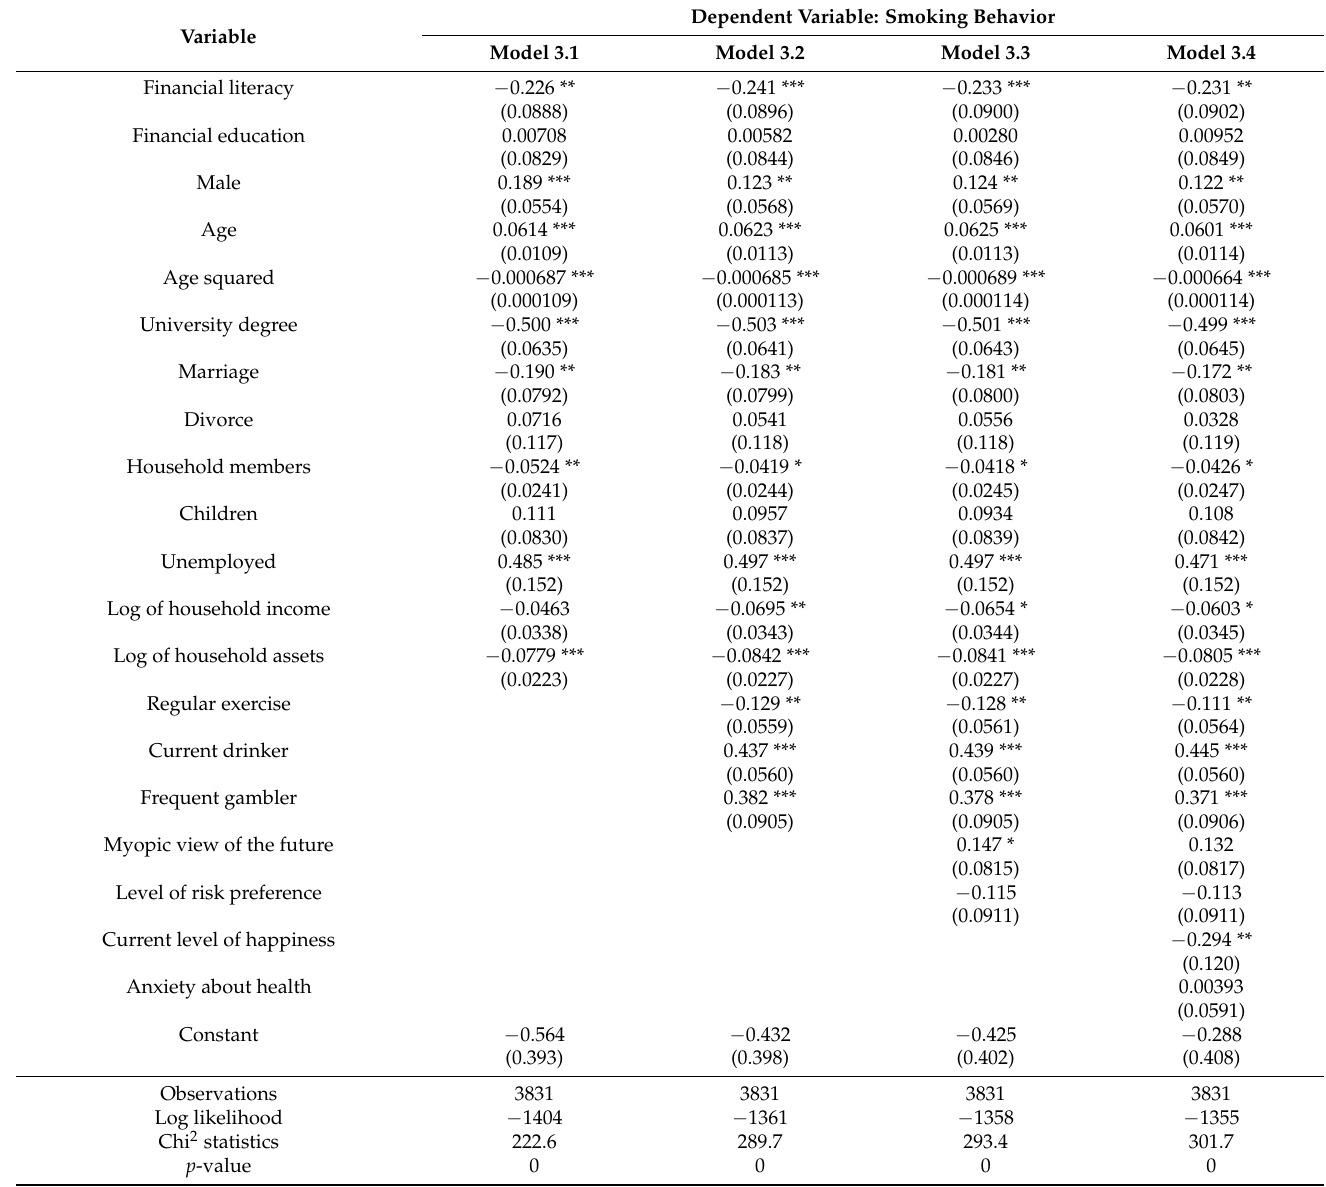
Table 8. Probit model regression results: financial literacy and financial education as the main explanatory variables.